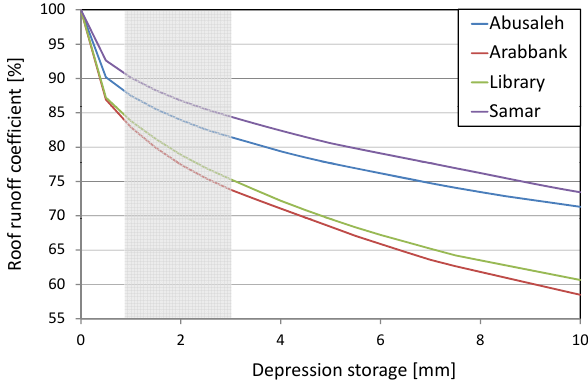
Fig. 5. Annual RC values calculated for all stations plotted against annual rainfall; DS is set to 2mm; dashed lines show 95% confi- dence band (green) and 95% prediction band (red).